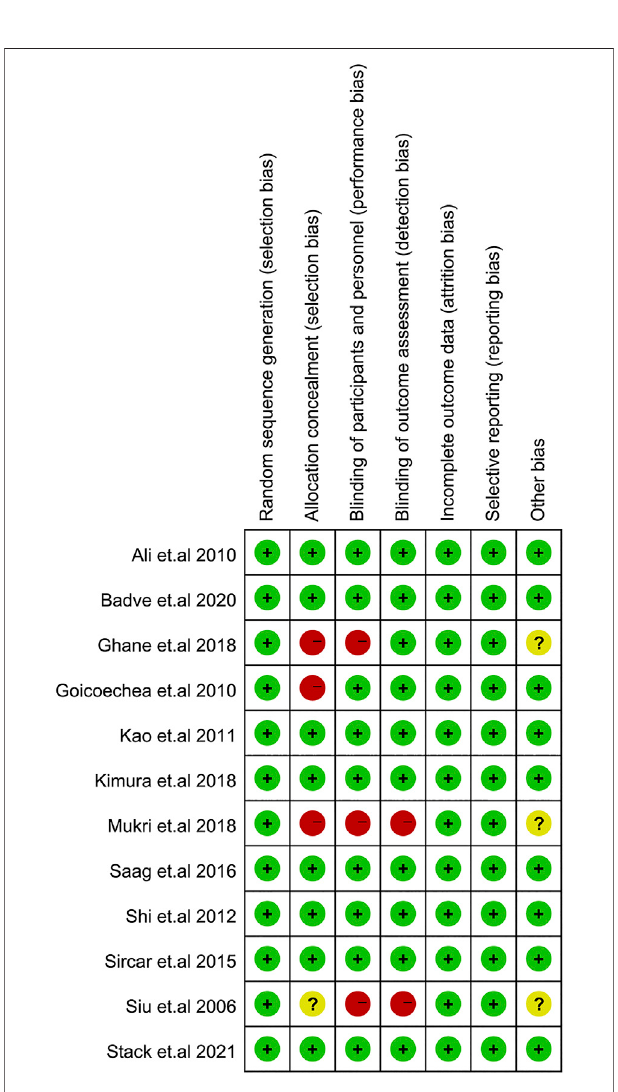
FIGURE 5 | Assessment of risk of bias items for the included